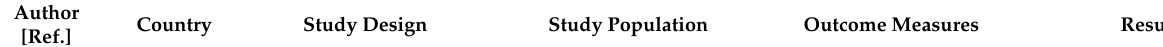
Table 2. Summary of studies on incidence of OM during the COVID-19